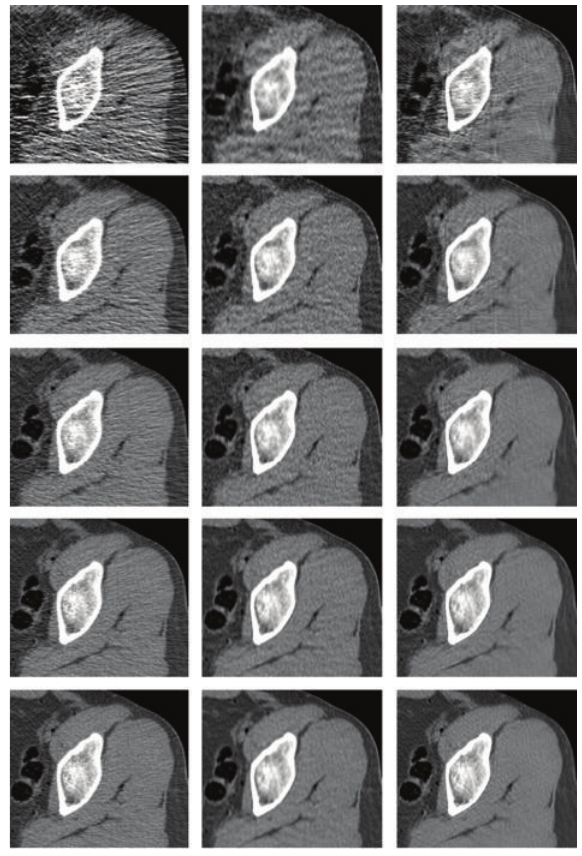
Figure 15: Columns, left to right: reconstruction by FBP, PWLS, and stage-II of our method. Rows, upper to lower: increasing